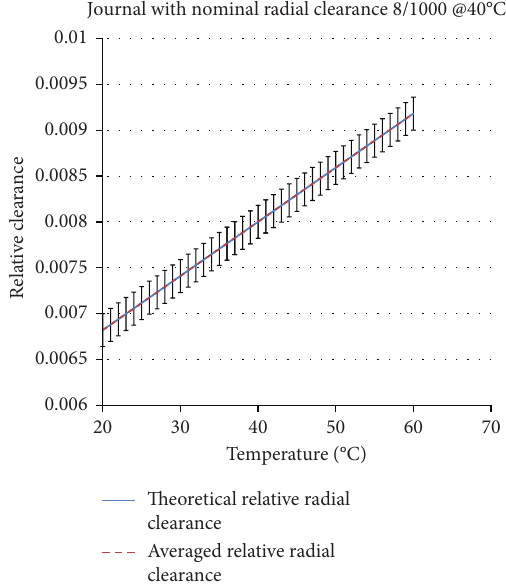
Figure 4: Relative radial clearance as a function of temperature.